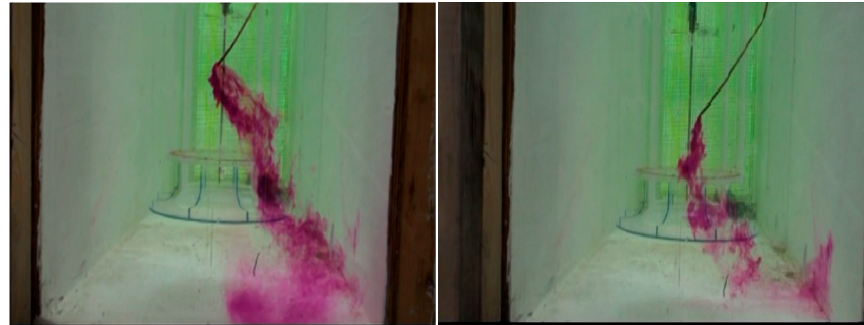
Figure 13. Flow instability and drifting behind the pump.